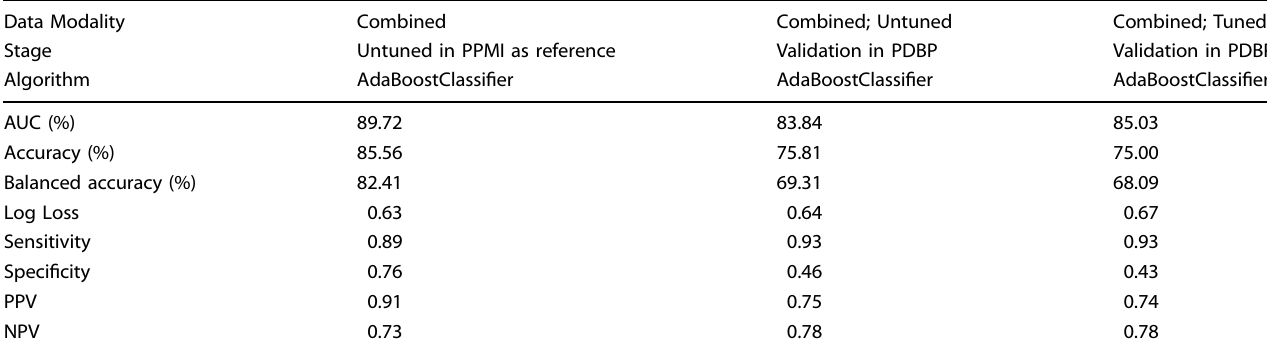
Table 4. Performance metric summaries comparing combined tuned and untuned model performance on PDBP validation